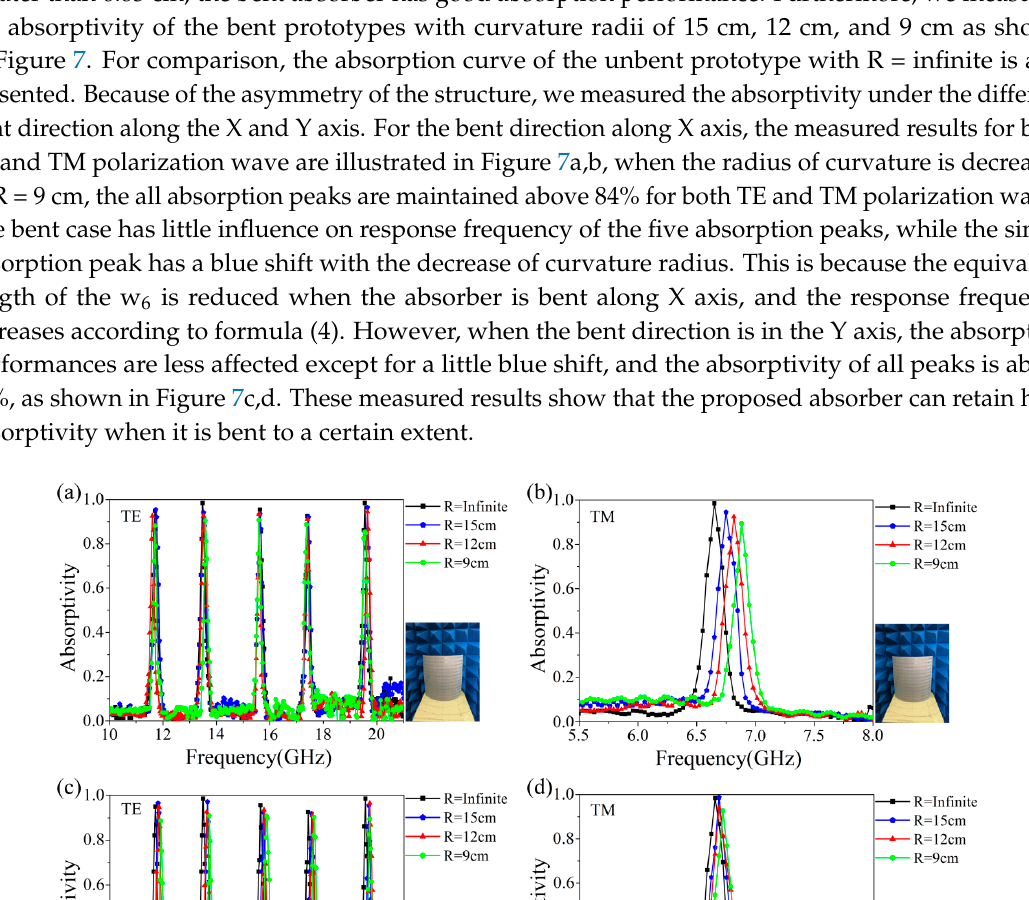
Figure 6. ( a ) Schematic diagram of the proposed absorber attached on the cylinder with radius of curvature R, ( b ) the relationship curve between R and the incident angle θ with m = 13.